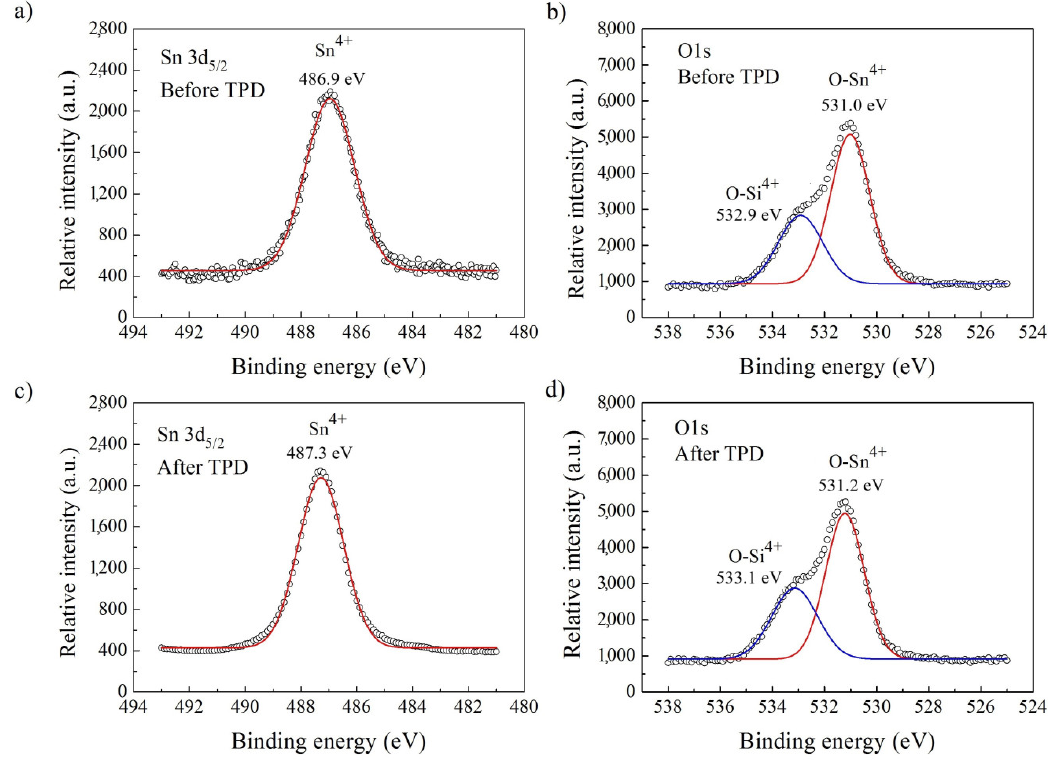
Figure 4. Registered XPS Sn3d 5/2 and O1s peaks, and deconvoluted components of the air-exposed VPD SnO 2 nanowires: ( a , b ) before TDS; ( c , d ) after the TDS process.